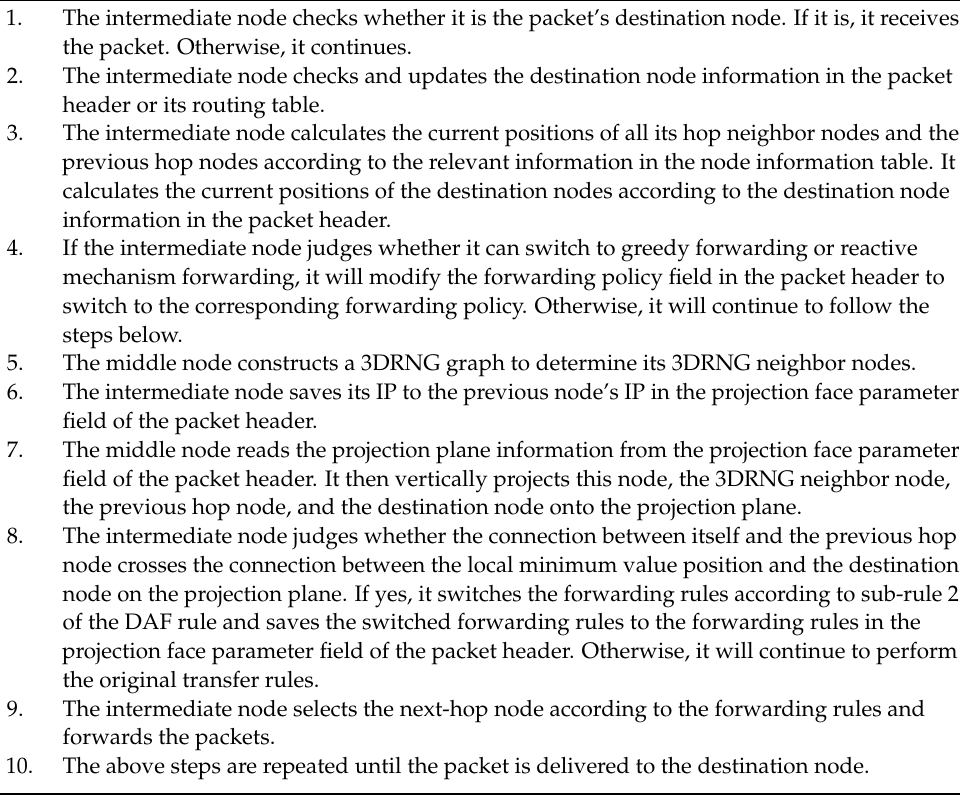
Algorithm 5: The projection face of the RGF protocol forwards